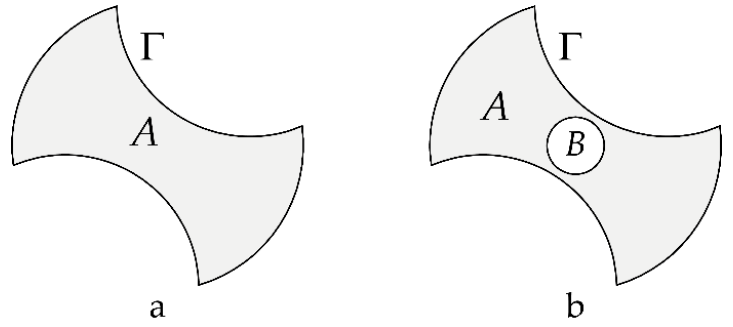
Figure 1. A drill cross-section, A , with the boundary Γ . ( a ) without hole, ( b ) with a hole, B